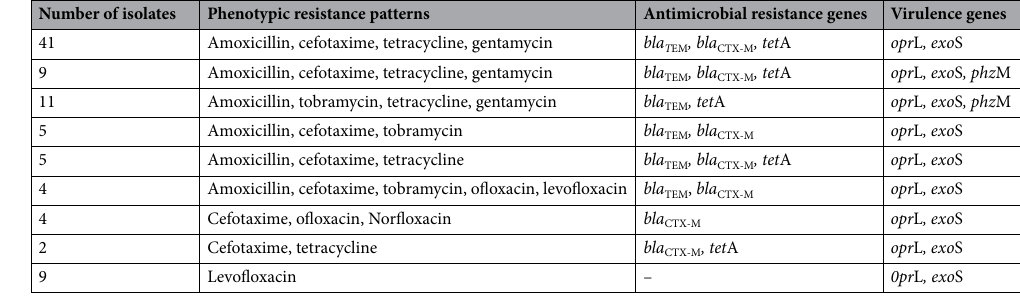
Table 6. The distribution of the multi-drug resistance patterns, antimicrobial resistance genes and virulence genes among the tested P. aeruginosa strains ( n = 90 ).